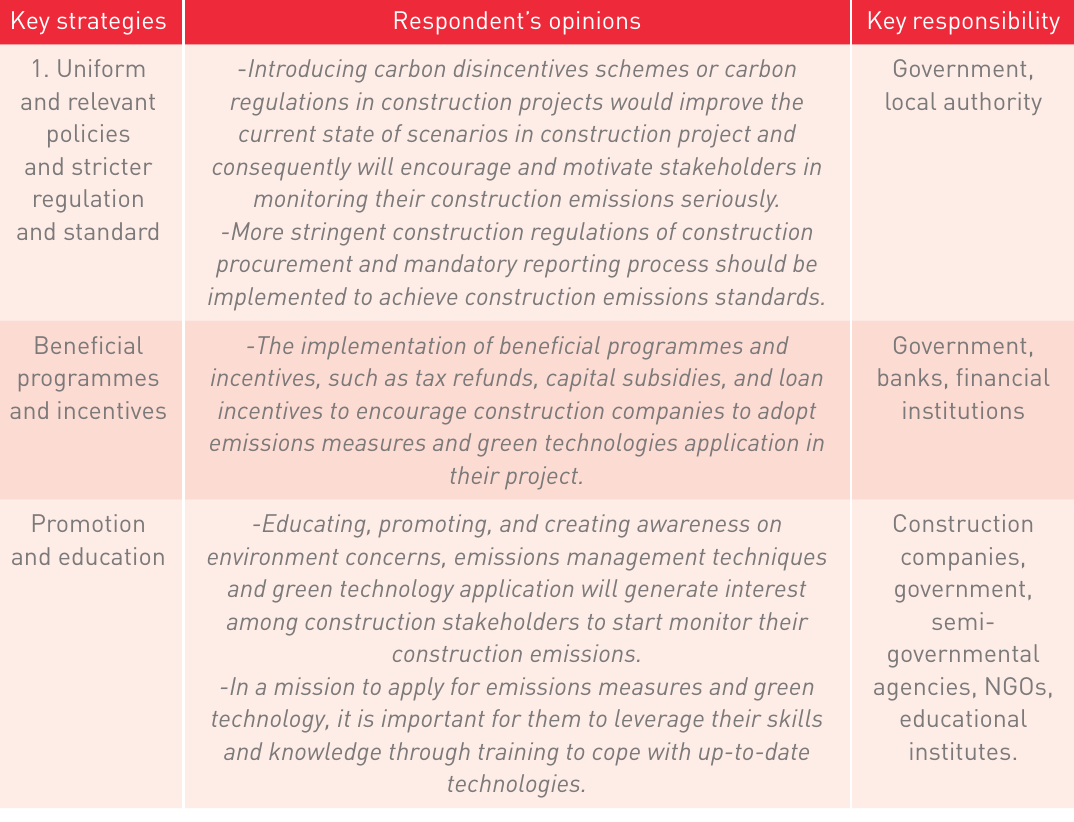
Emissions strategies are based on participant’s opinions to improve stakeholder’s